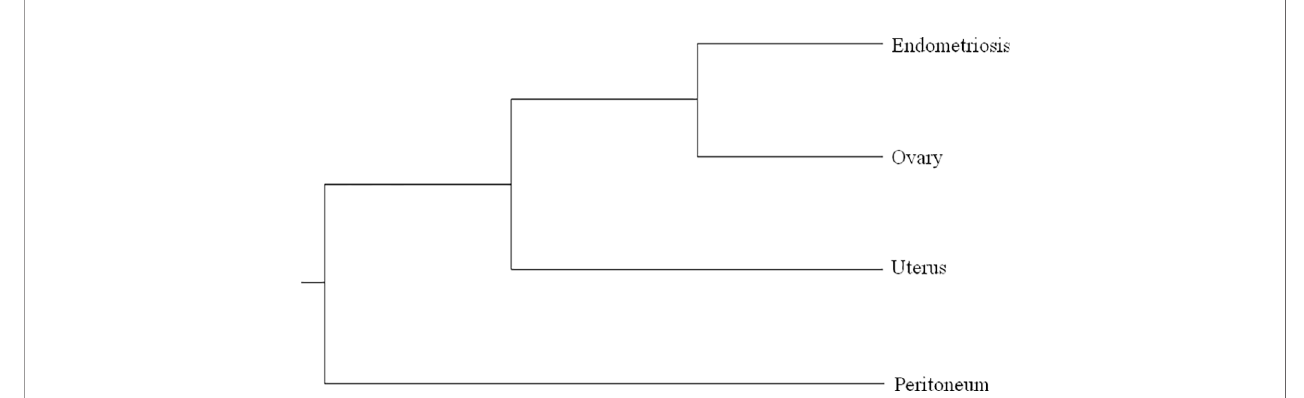
FIGURE 2 | Phylogenetic tree based on Multiple Alignment using Fast Fourier Transform (MAFFT) with the unweighted pair group method with arithmetic mean and the Jukes – Cantor substitution model. All the samples of case 1 are very close to each other, as we found a limited number of mutations in heteroplasmy, 4 of which in the sample of the peritoneum and 2 in endometriosis